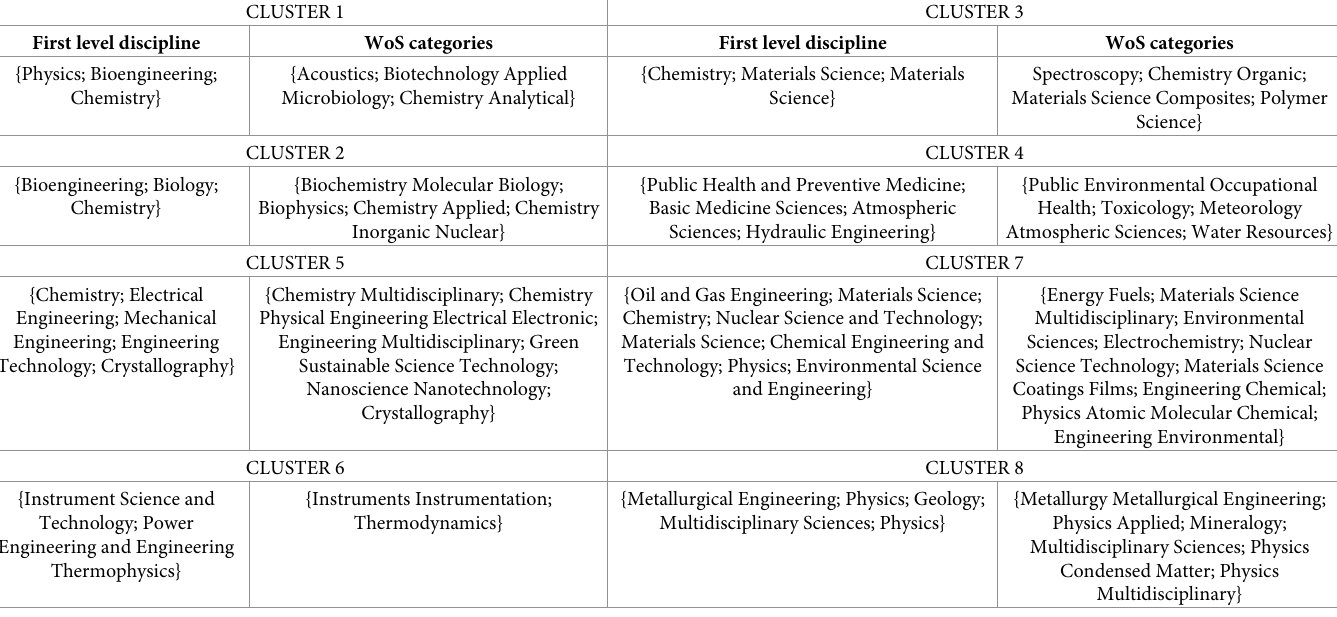
Table 6. The block clustering of the disciplines in